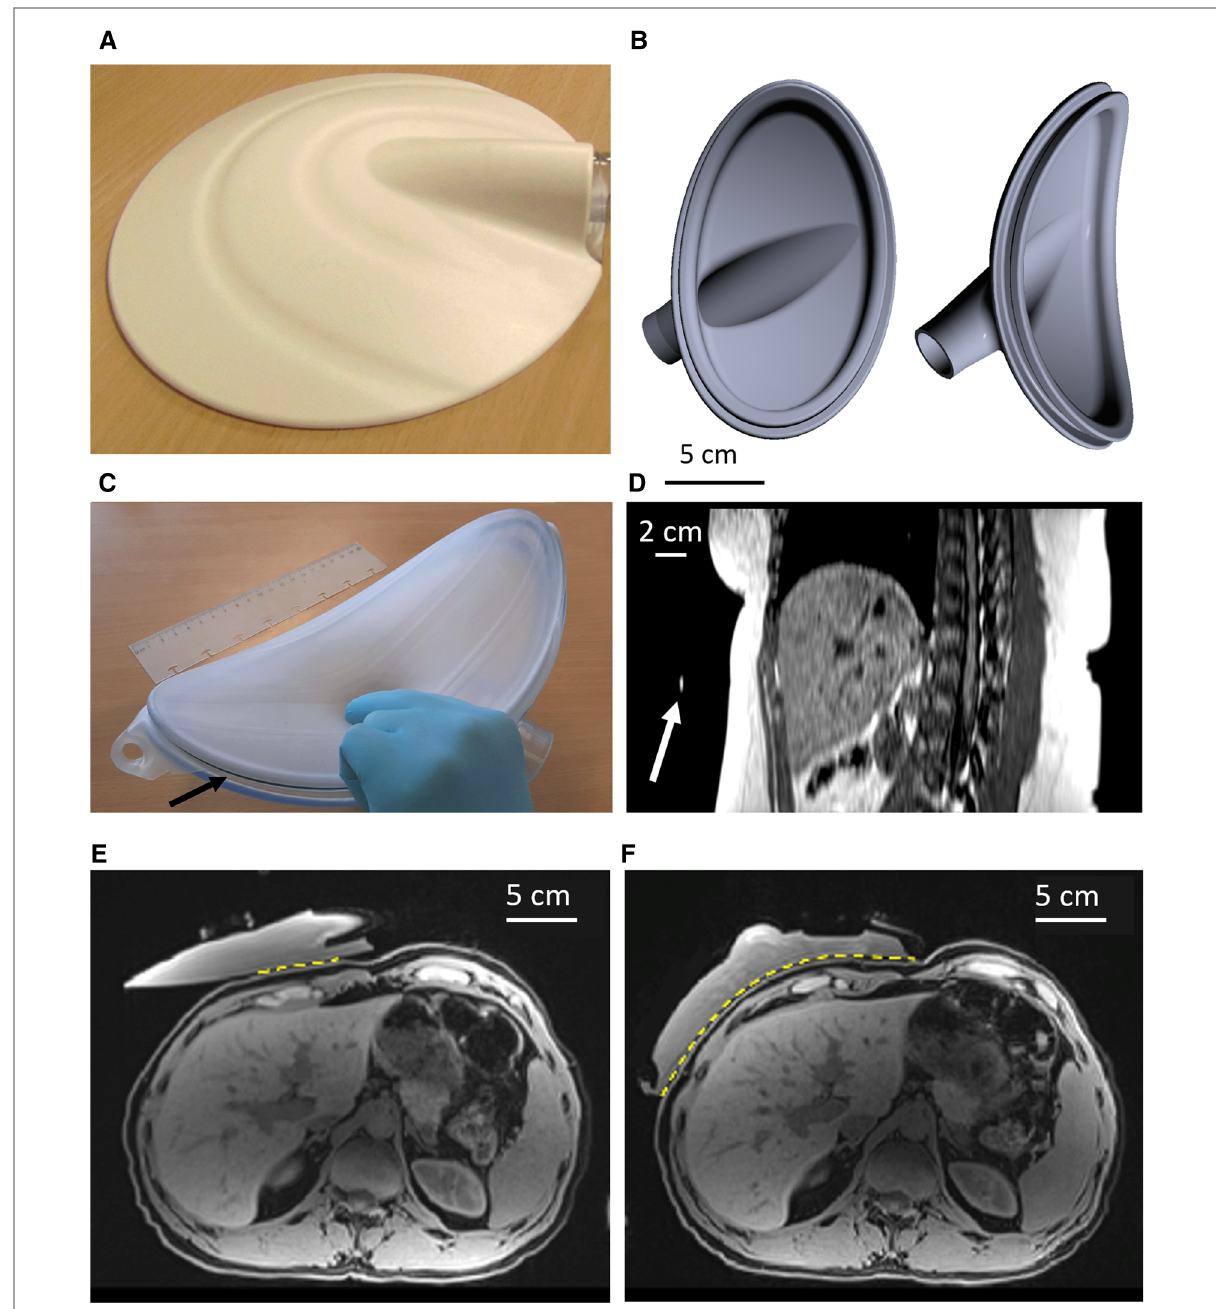
FIGURE 1 ( A ) picture of the commercial Resoundant MRE passive driver. ( B ) Illustration of the custom passive driver, shown as a computer model, without its biocompatible membrane. ( C ) Front view of the custom driver equipped with its membrane. The arrow indicates the seal. ( D ) MPR sagittal oblique reconstructed plane from 3D breath-hold data. The arrow indicates the position of the marker, con fi rming the correct positioning of the passive driver. ( E ) Fat-suppressed T1w MR images of water- fi lled commercial driver vs. the custom driver ( F ) on the same volunteer. The yellow dotted line highlights the transmitting contact surface for the vibrational excitation. MRE, magnetic resonance elastography; MR, magnetic resonance; MPR, multiplanar